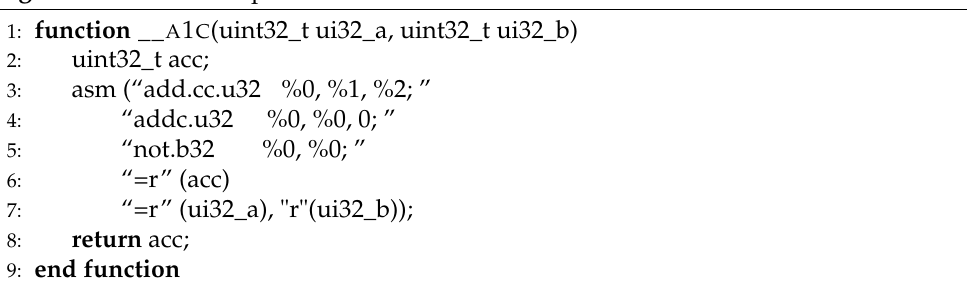
Algorithm 2 One’s complement